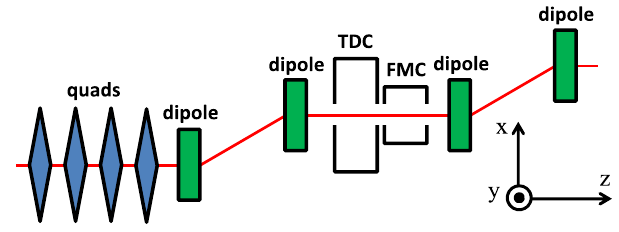
FIG. 3. Emittance exchanger in a double dogleg configuration. The abbreviations TDC and FMC denote “ transverse deflecting cavity ” and “ fundamental mode cavity.